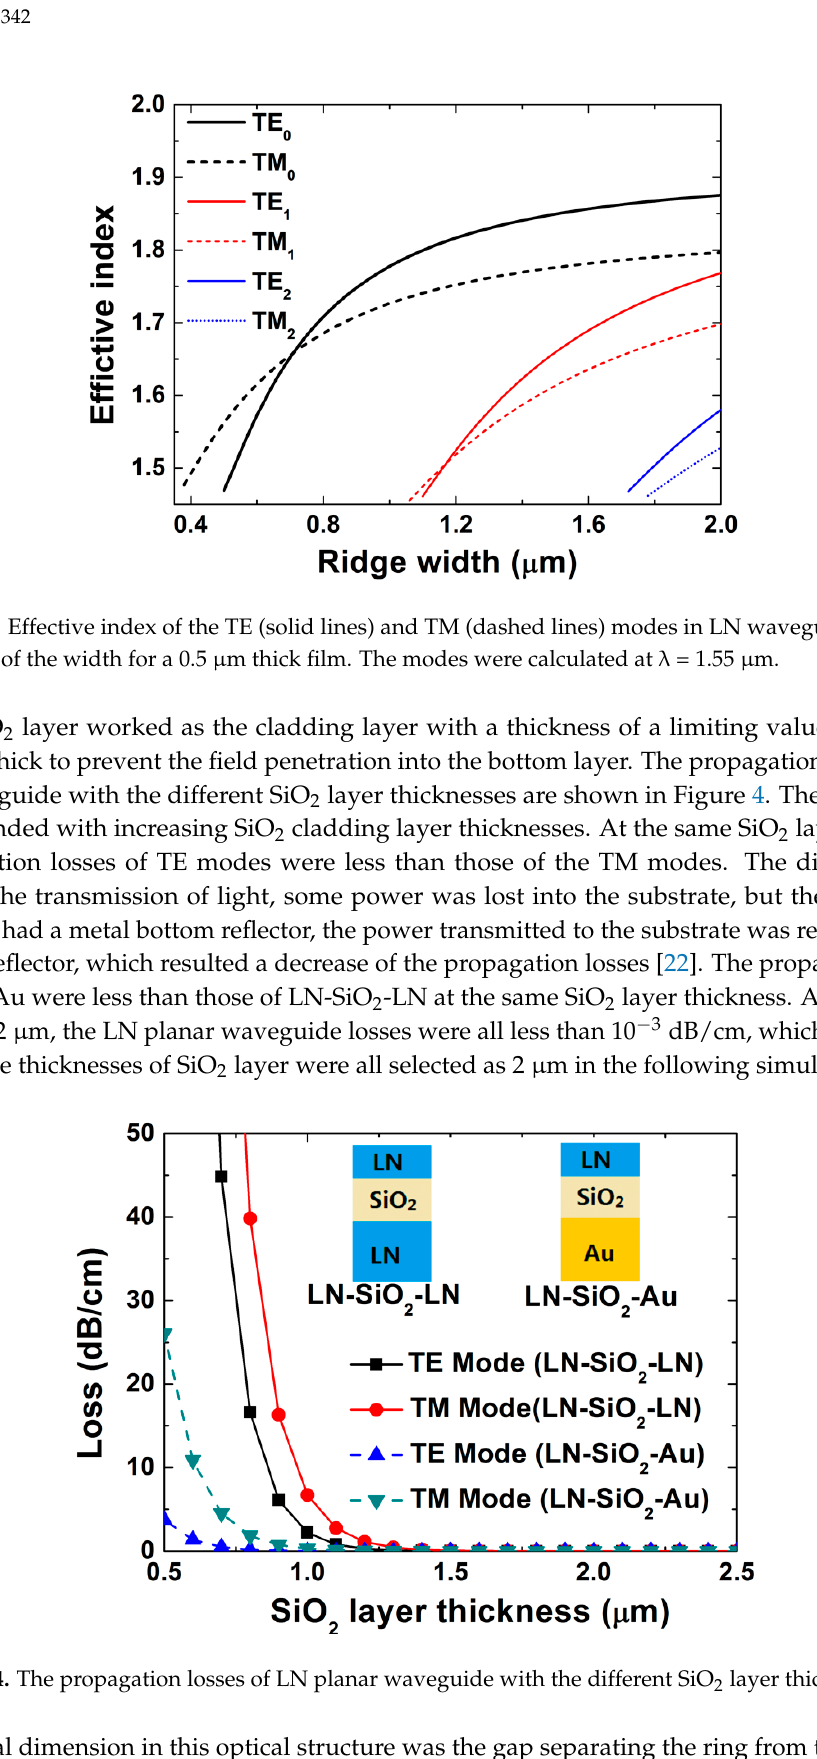
Figure 4. The propagation losses of LN planar waveguide with the different SiO 2 layer thicknesses.